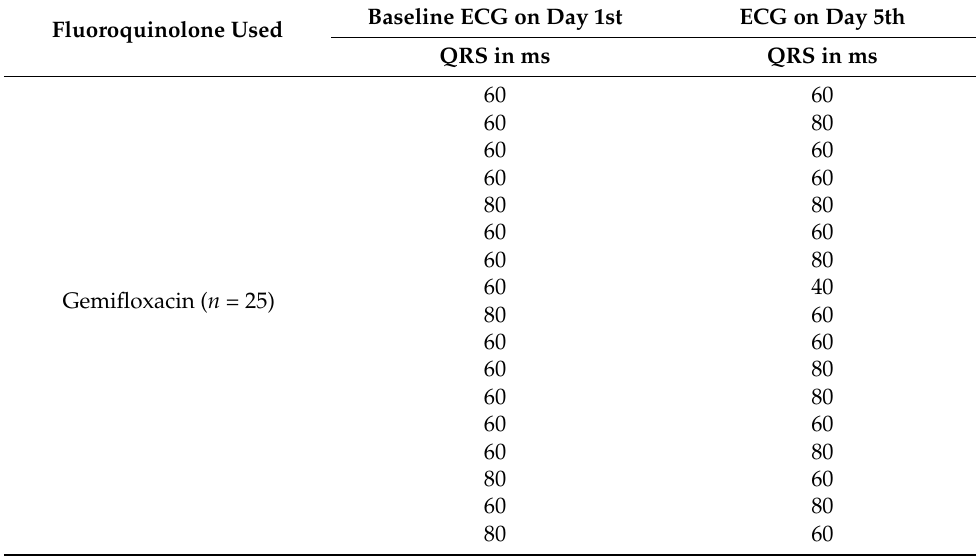
Table 8. Baseline QRS (ms) complex and QRS (ms) complex on day five in the Gemifloxacin group. Fluoroquinolone